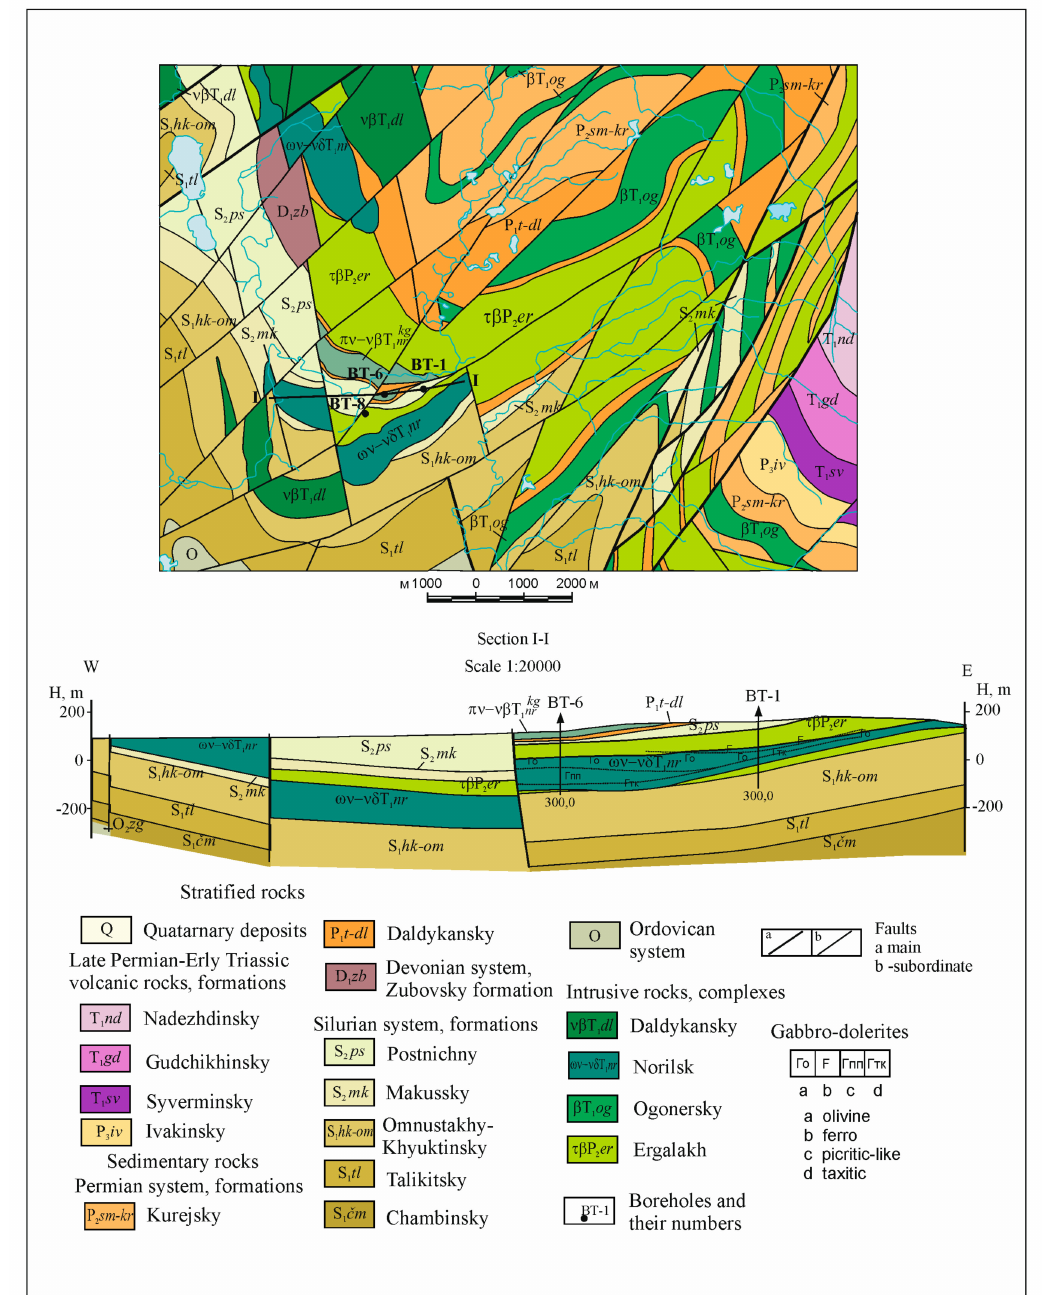
Figure 2. Geological map of the Turumakit area modified after Norilskgeologia LLC